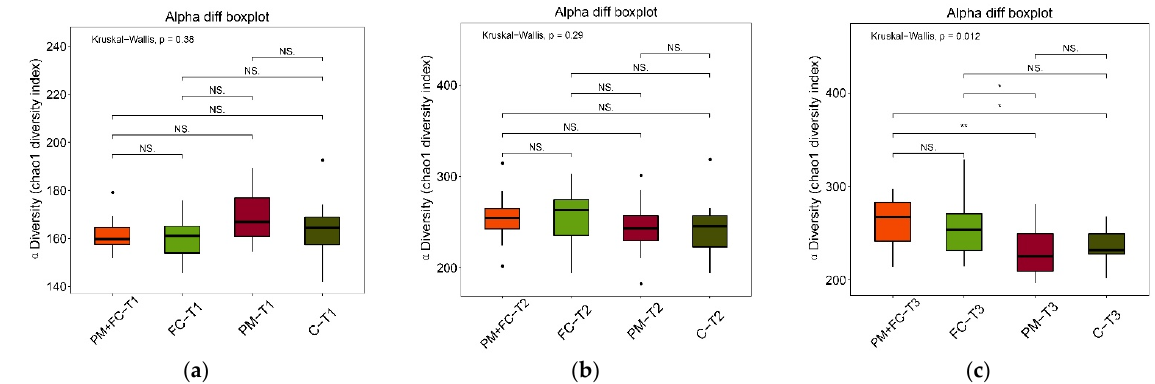
Figure 9. α diversity of gut microbiota at T1 ( a ), T2 ( b ), and T3 ( c ). NS p ≥ 0.05, * p < 0.05, ** p < 0.01.